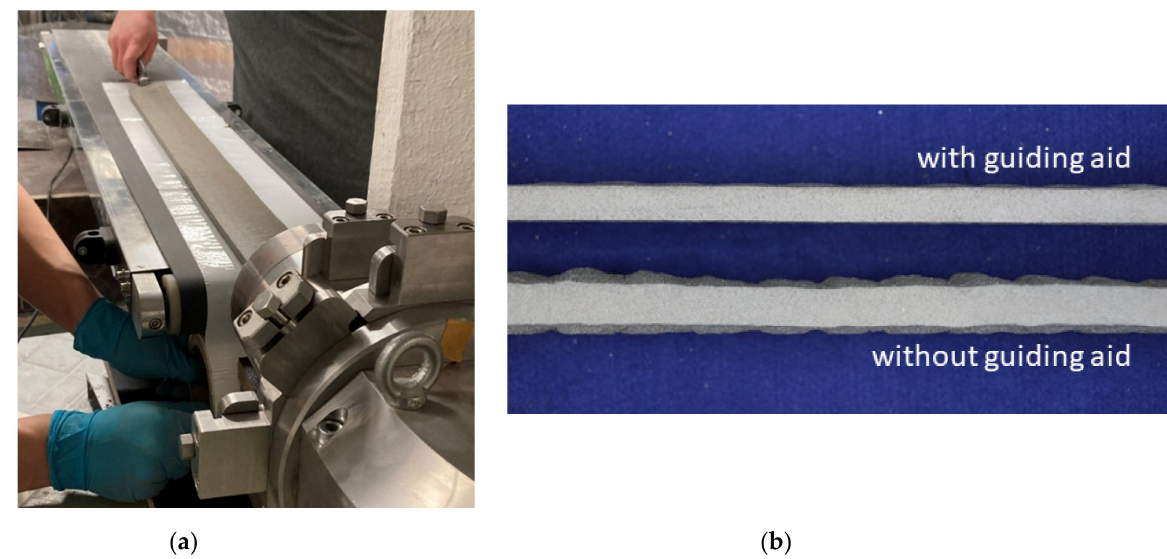
Figure 11. ( a ) Extrusions with a guiding aid; ( b ) Comparison of extrusion specimens with and without a guiding aid in a cross-section.